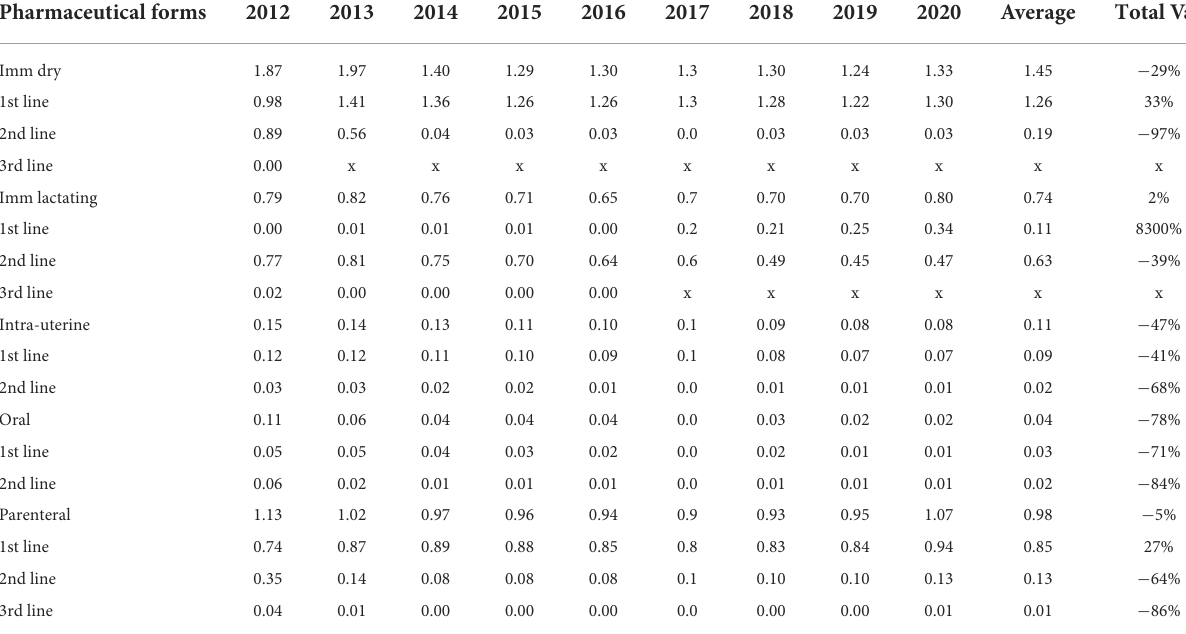
TABLE 2 Yearly antimicrobial consumption, in DDDA NAT units, from 2012 to 2020 by pharmaceutical form and by line, in consumption and overall variation (Total Var). Pharmaceutical forms